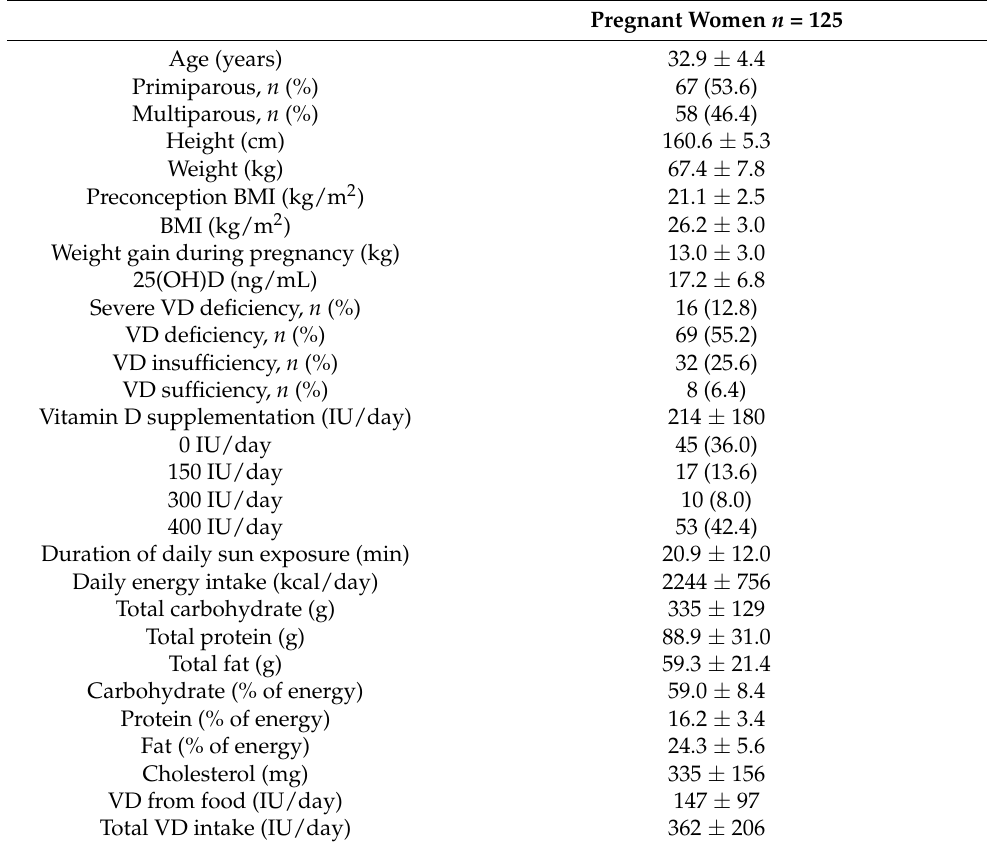
Table 1. Demographic characteristics and dietary intake details of the participants.